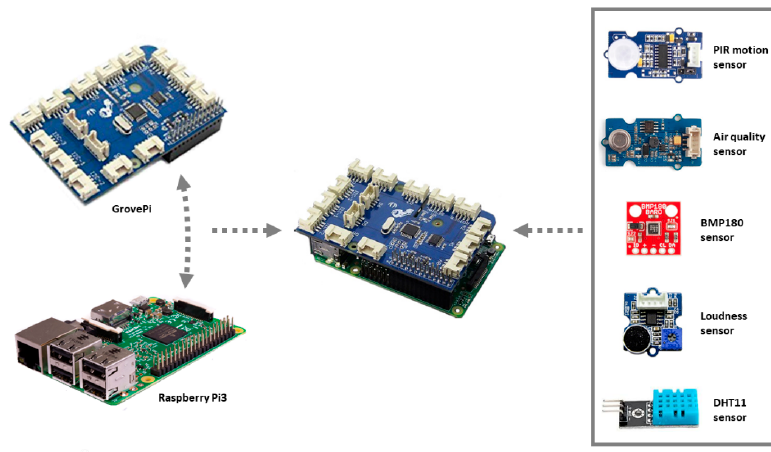
Figure 5. Hardware prototype components.